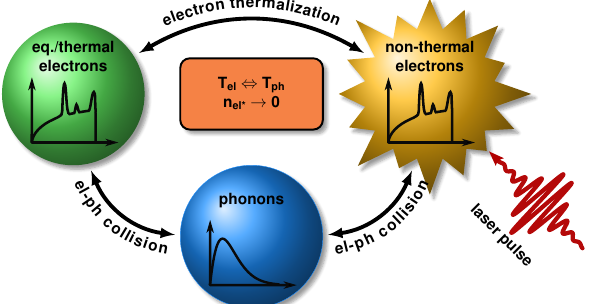
Figure 1. Schematic illustration of the subsystems and the interactions in the extended two-temperature model. The laser generates non-equilibrium (non-thermal) electrons. They thermalize by collisions with the unaffected (thermal) electrons. Thus, the particle density of excited electrons n el* decreases during thermalization. Moreover, collisions of electrons with phonons lead to a heating of the crystal lattice. Both non-thermal and thermal electrons contribute to this relaxation process, which results in a joint electron and phonon